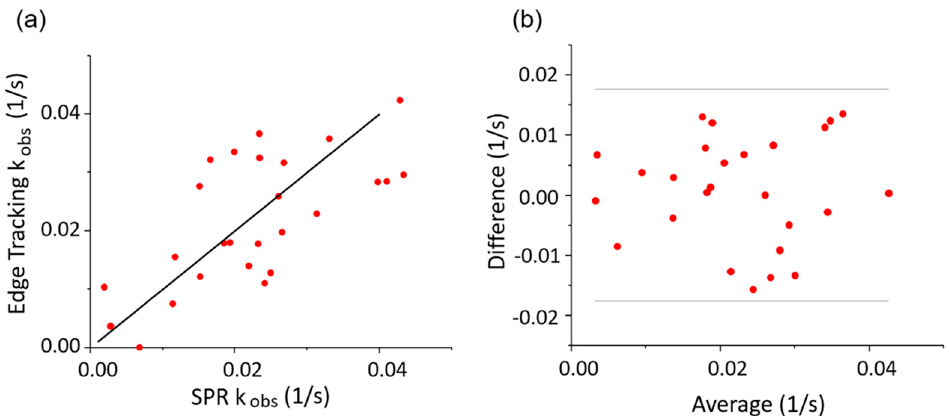
Figure 4. ( a ) Plot of the observed kinetics constant from edge tracking and the SPR method for simultaneously measured cells. Each dot represents a single cell that has both SPR data and edge tracking data for the same binding events. The solid black line represents the expected one-to-one ratio. ( b ) The Bland–Altman plot shows the discrepancies between SPR and the edge tracking algorithm in more detail. The y-axis represents the k obs di ff erence between the two methods (edge tracking k obs − SPR k obs ), and the x-axis represents the average k obs of the two methods ((edge tracking k obs + SPR k obs ) / 2). The standard deviation of the di ff erence between the two methods is 0.009 s − 1 . The gray lines mark plus and minus at two times the standard deviation, ± 0.018 s − 1 .